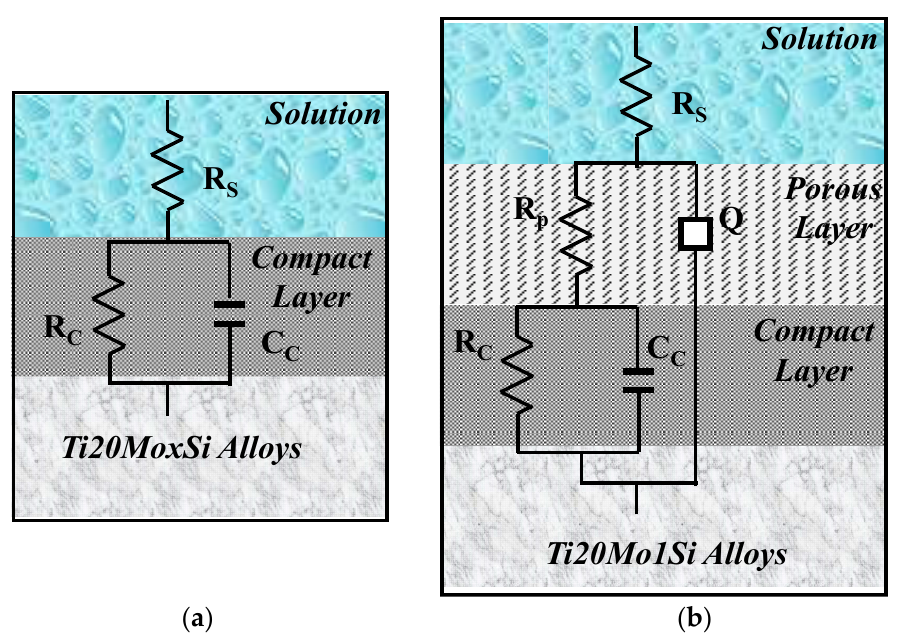
Figure 6. The equivalent circuit and the solution–alloy interface for the following: ( a ) Ti20Mo, Ti20Mo0.5Si, Ti20Mo0.75 Si; ( b ) Ti20Mo1.0Si.